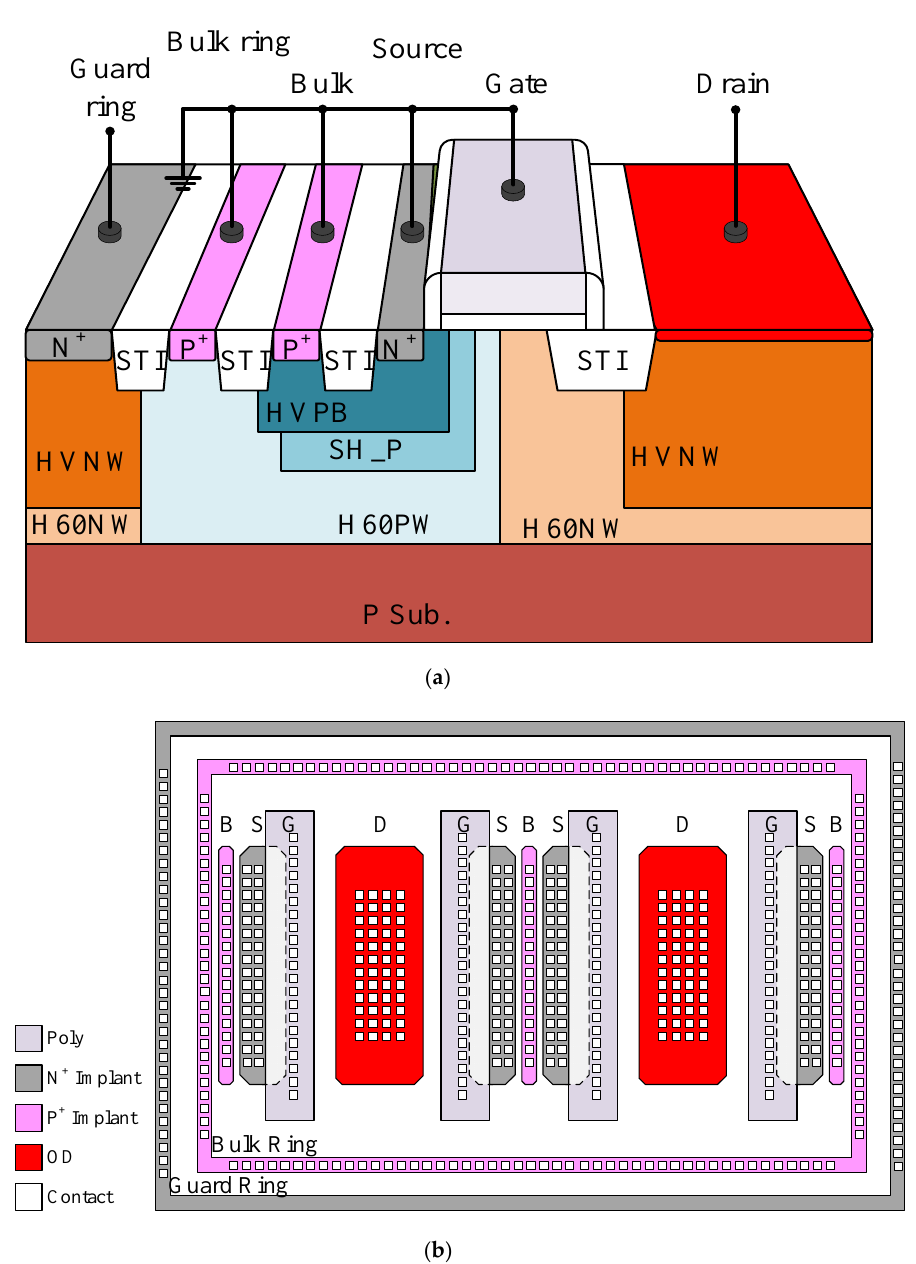
Figure 2. ( a ) 3D structure view and ( b ) layout diagram of the HV nLDMOS with the drain electrode-embedded full Schottky device modulation.